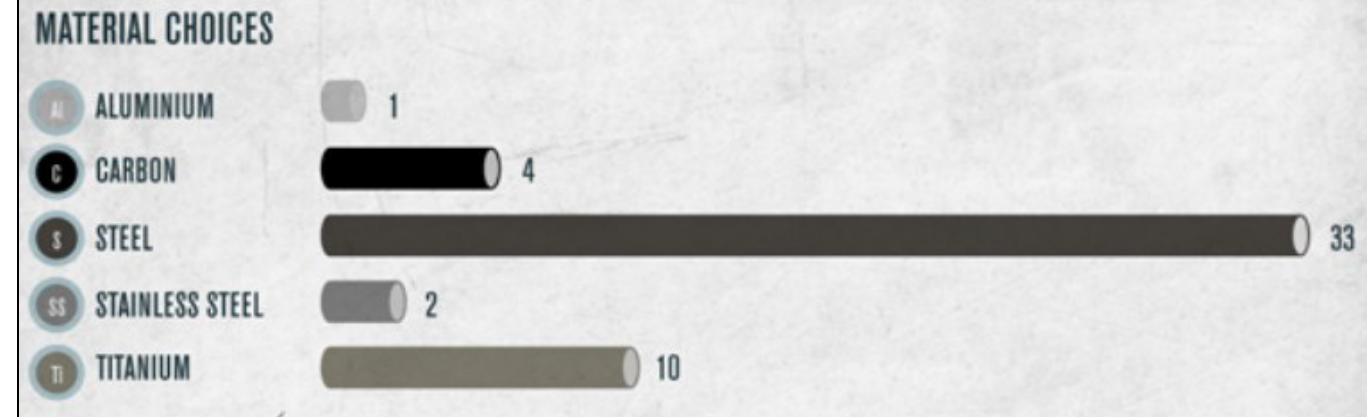
Figure 2: New England framebuilder materials Source: NE Family Tree website.